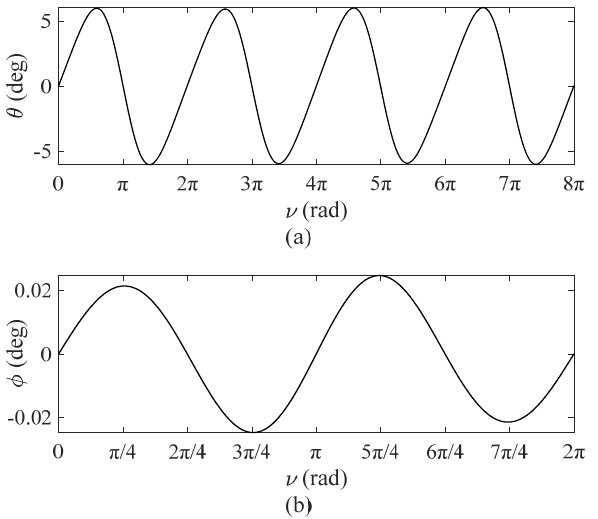
Figure 3. Tether vibration angles, e = 0.1: ( a ) tether in-plane angles versus ν ; ( b ) tether out-plane vibration angles versus ν .